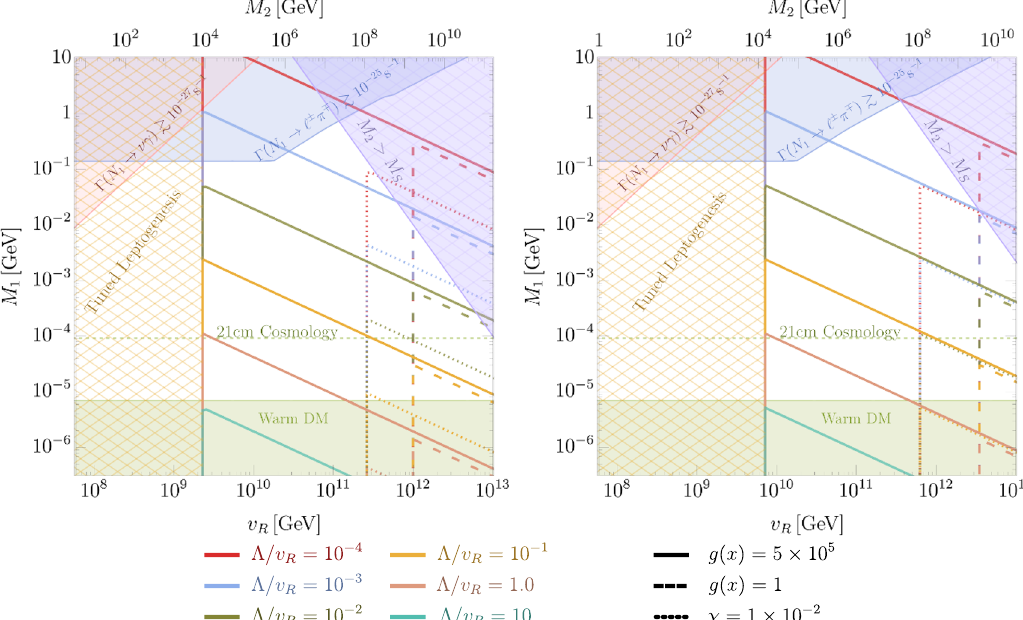
Figure 15 . The parameter space where N 1 DM from freeze-in and N 2 leptogenesis can naturally be realized without radiative corrections affecting the stability of N 1 DM and in accord with the active neutrino mass spectrum. The unhatched shaded regions are constraints solely on N 1 DM from freeze-in as in figure 3. In the hatched gold region, the baryon asymmetry generated by N 2 , at the maximum possible ηY 2 ’ 0 . 1 Y therm , is unable to match the observed baryon asymmetry with g ( x ) set to its largest natural value, and y 33 constrained by neutrino masses. The right, downward sloping contours indicate where the radiative corrections to y i 1 are sufficiently large that they must be unnaturally tuned with tree contributions to keep N 1 DM stable when g ( x ) is set to its largest natural value, and y 33 set by consistent neutrino masses. Each contour corresponds to a specific Λ /v R , as shown by the legend at the bottom. The dashed and dotted contours show the same region when M 2 and M 3 are comparable, ( g ( x ) = 1 , dashed) and m ( ss ) and m (5) are as naturally 3 3 degenerate as can be ( g ( x ) at χ min , dotted). Naturalness and neutrino mass consistency excludes areas with too low or high values of v R , and places a strong upper bound on the cutoff Λ . Regions with larger M 1 are only allowed if Λ < v R , as occurs for the model of section 7. The hatched violet region shows the inconsistent region where the mass of N 2 is greater than the mass of the heavy √ −√ fermion that generates it. Left: We fix m 22 = ∆ m 2 and m 33 = ∆ m 2 + ∆ m 2 resembling atm atm sol the Inverted Hierarchy. Consequently, m 22 ( m 22 − m 33 ) ’ (0 . 1 eV) 2 and y 2 is relatively large 33